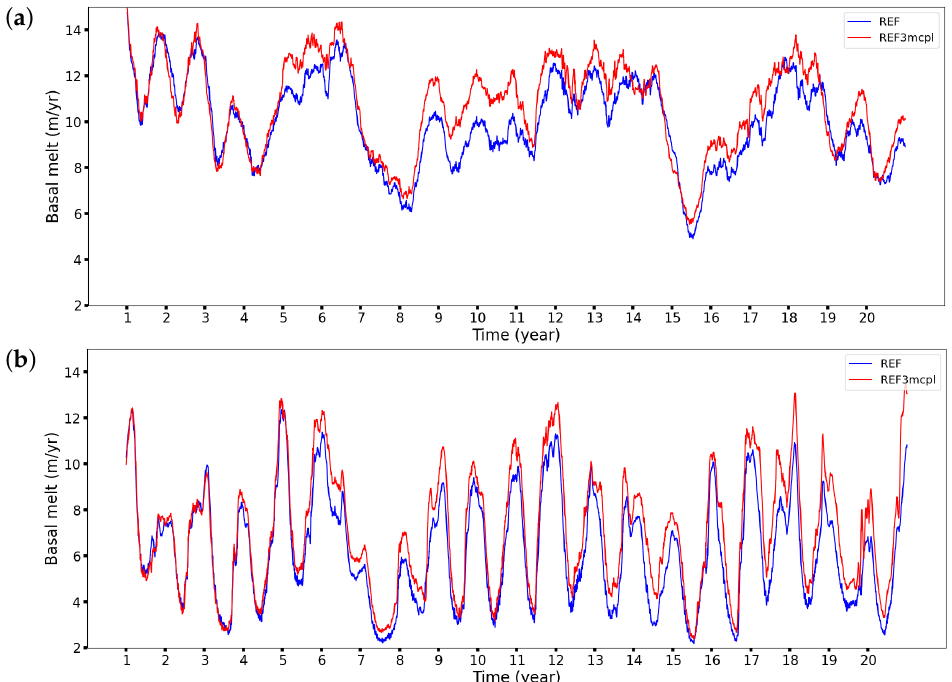
Figure 3. Area-averaged basal melt rate in the TIS ( a ) and MUIS ( b ) cavities for the REF (blue) and REF3mcpl (red) simulations over the 1995–2014 period. The TIS mean basal melt rate amounts to 10 ± 1.88 m year − 1 for REF and 10.68 ± 1.95 m year − 1 for REF3mcpl. The MUIS mean basal melt rate amounts to 6.2 ± 2.38 m year − 1 for REF and 7.09 ± 2.58 m year − 1 for